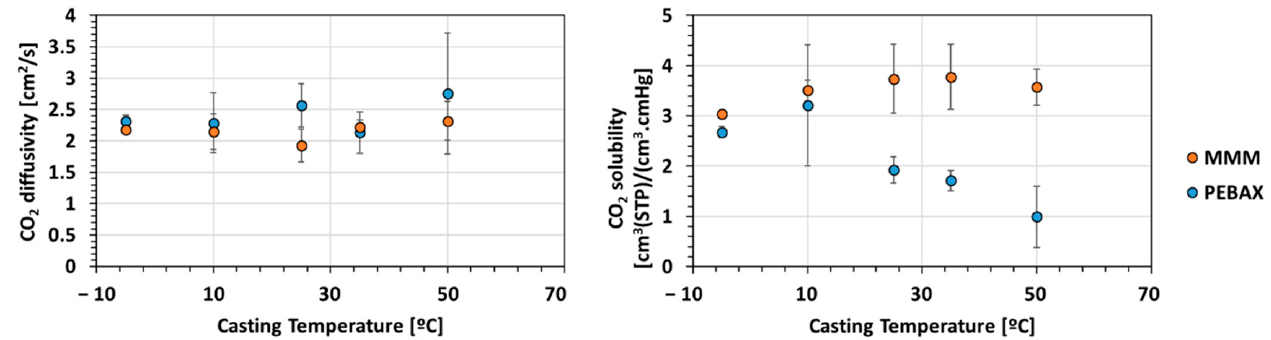
Figure 9. Variation of CO 2 diffusivity and solubility as a function of the casting temperature for PEBAX (Blue) and MMMs (Orange).